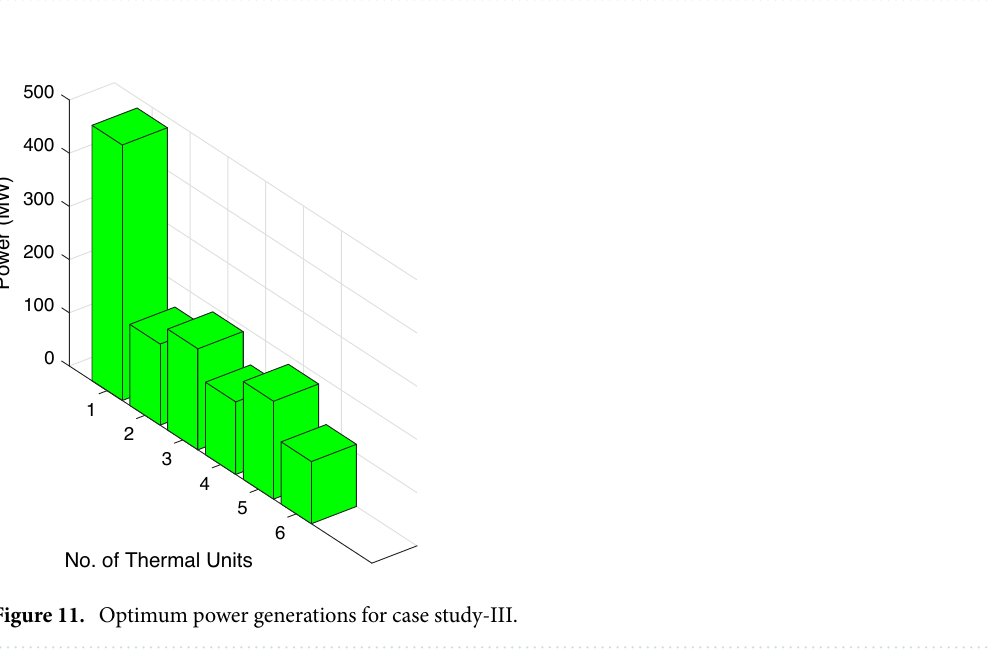
Table 7. Performance analysis of ABWO comparing other approaches case study-II. Significant values are in bold.